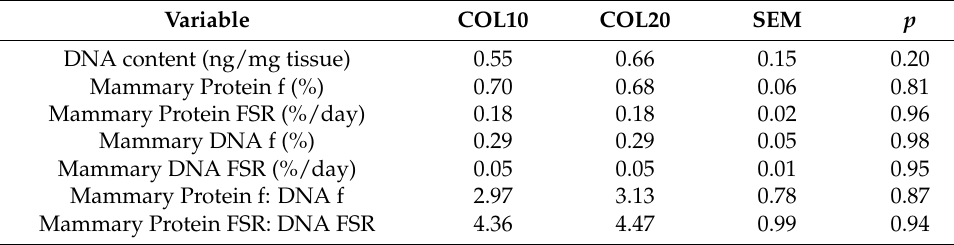
Figure 4. The effect of day and colostrum treatment on the proportion of parenchyma composed of epithelial tissue and percent epithelial and stromal cell proliferation index. ( A ) Proportion of parenchymal tissue composed of epithelium (parenchymal epithelial area; PEA) and ( B ) percent of epithelial and stromal cells in parenchymal compartment stained with KI67 as a marker of proliferating population in mammary tissue of baseline ( n = 6; gray) animals collected